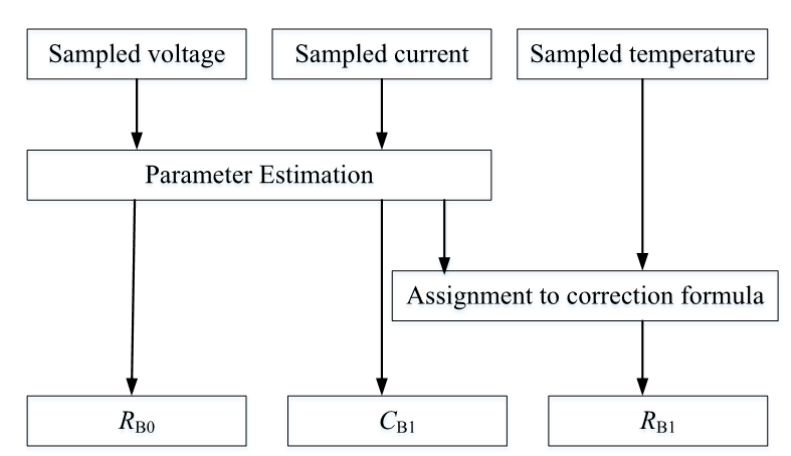
Figure 14. Flow chart of battery-status estimation system.